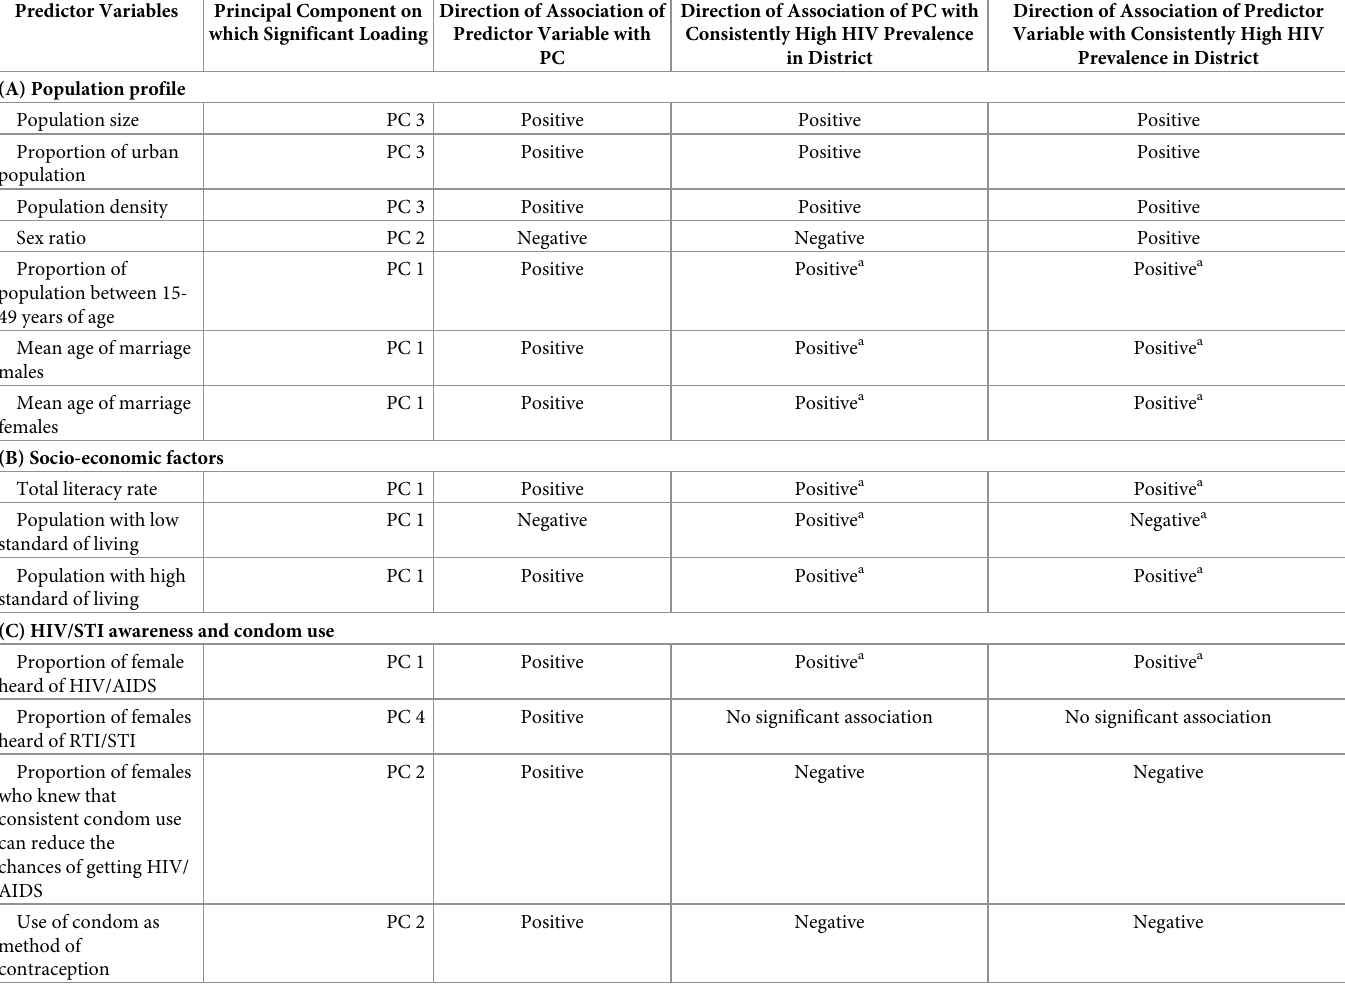
Table 5. Direction of association of predictor variables and principal components with consistently high HIV prevalence in Indian districts based on multi level analysis. Predictor Variables Principal Component on Direction of Association of which Significant Loading Predictor Variable